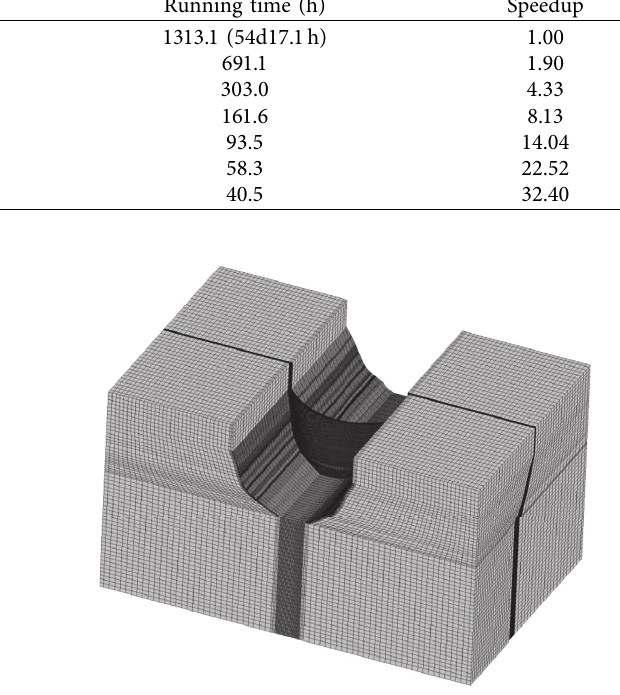
Figure 10: The dam-foundation model.